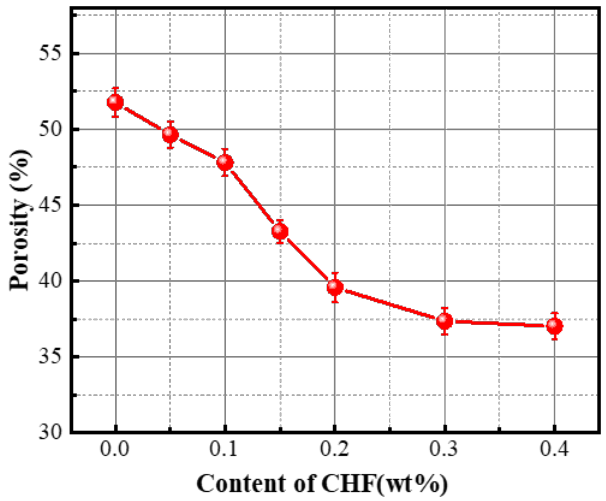
Figure 7. Influence of the content of CHF on the porosity of the material.